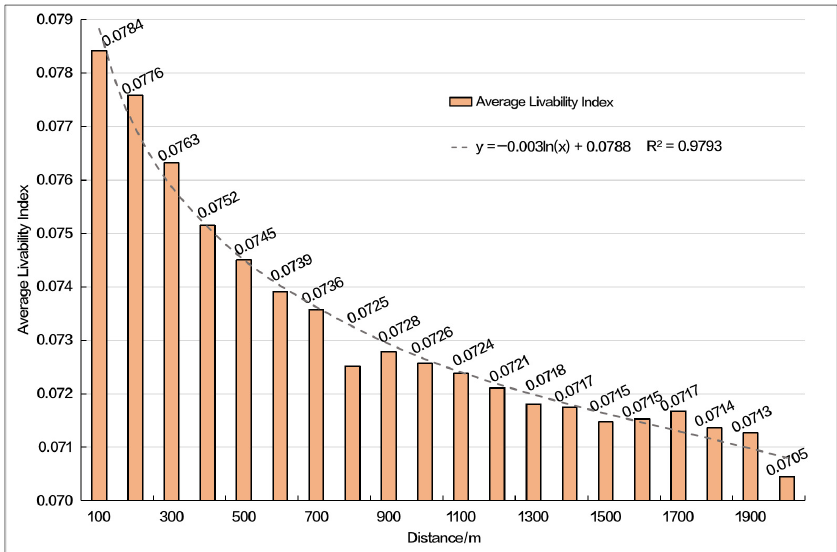
Figure 5. Average Livability Index in Different Buffers.